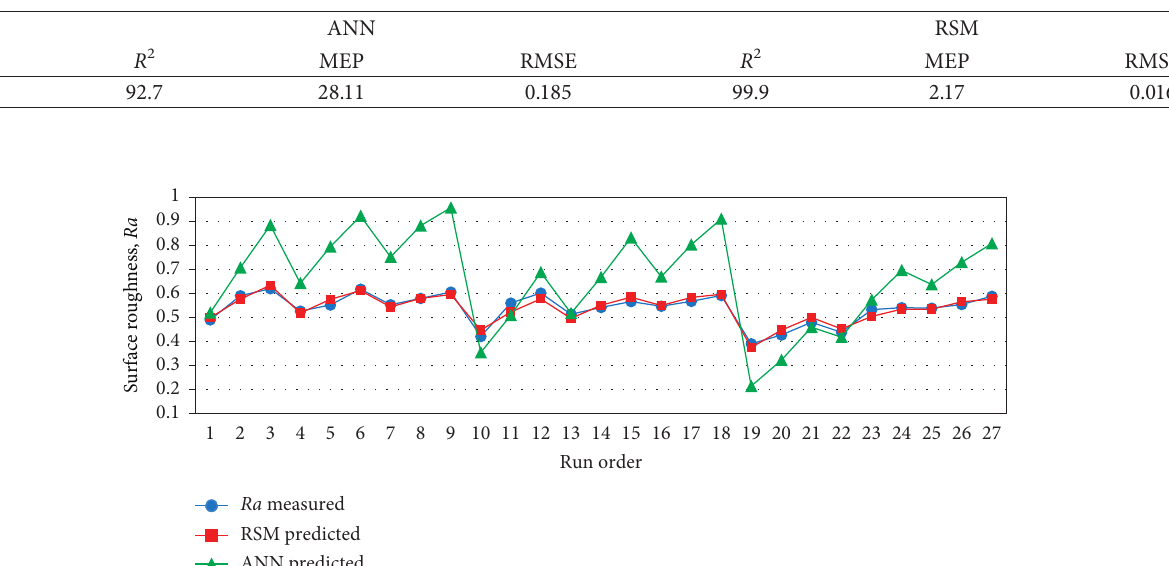
Figure 7: Predicted RSM values for surface roughness on f and ap . Table 6: Comparison of ANN and RSM model.